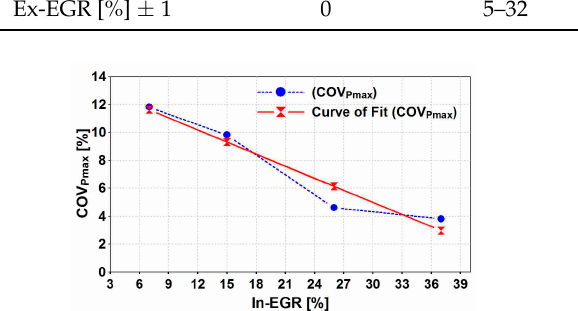
Figure 8. Cyclic variability of P max due to variation of In-EGR setting (rpm = 3000, IMEP = 2.1 bar, T epc = 425 – 530 K).